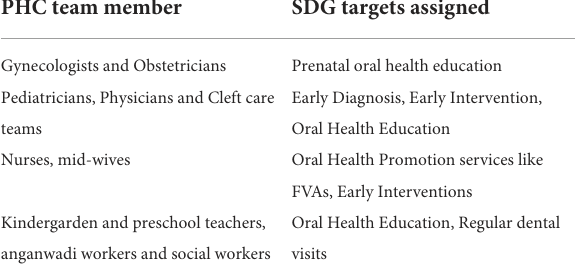
TABLE 4 Primary health care